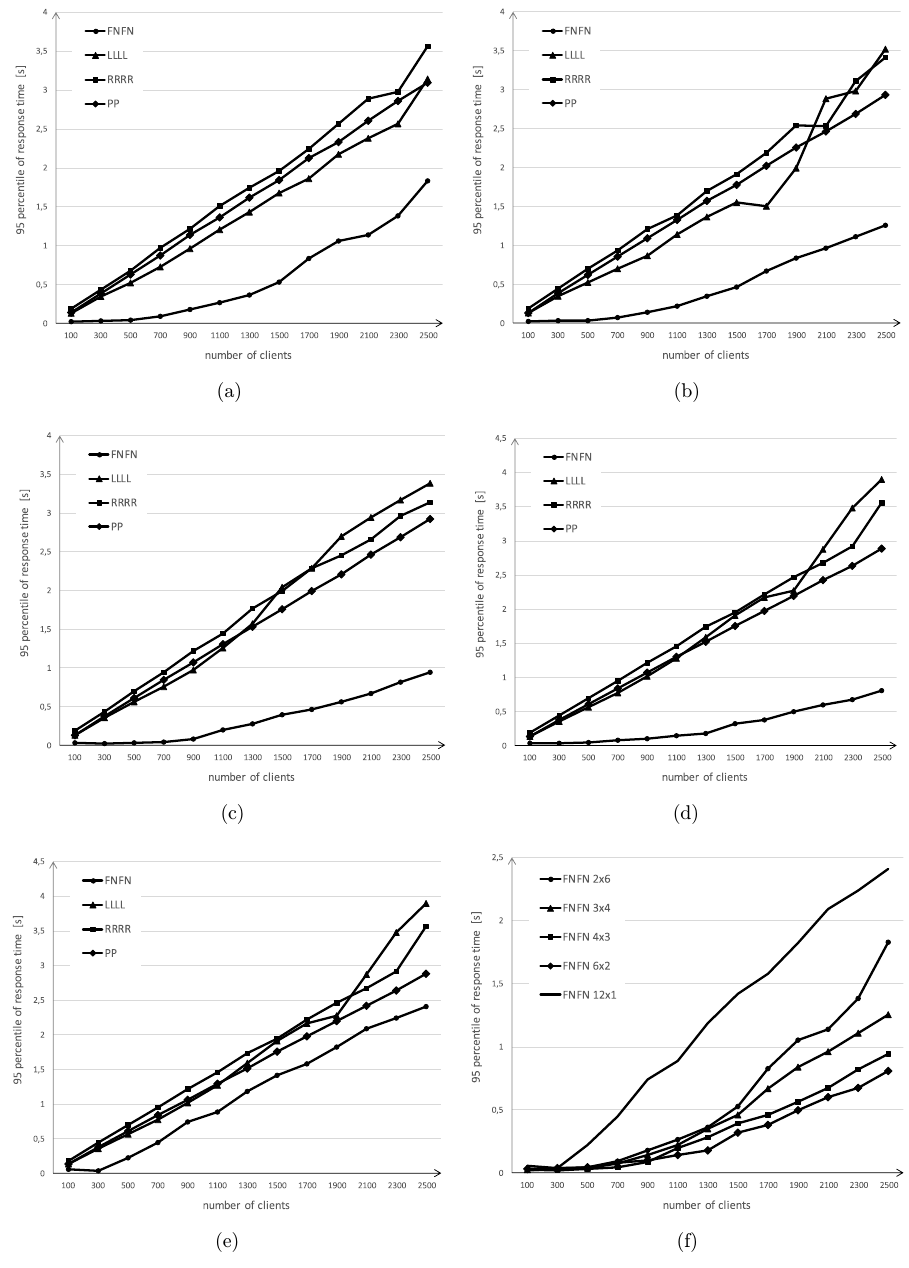
Fig. 6. The 95 percentile of request response time in the load function for the region containing 12 Web servers: (a) 2 zones, 6 servers in each zone ( 2 (cid:5) 6 ), (b) 3 (cid:5) 4 , (c) 4 (cid:5) 3 , (d) 6 (cid:5) 2 , (e) 12 (cid:5) 1 and (f) comparison of results for FNFN